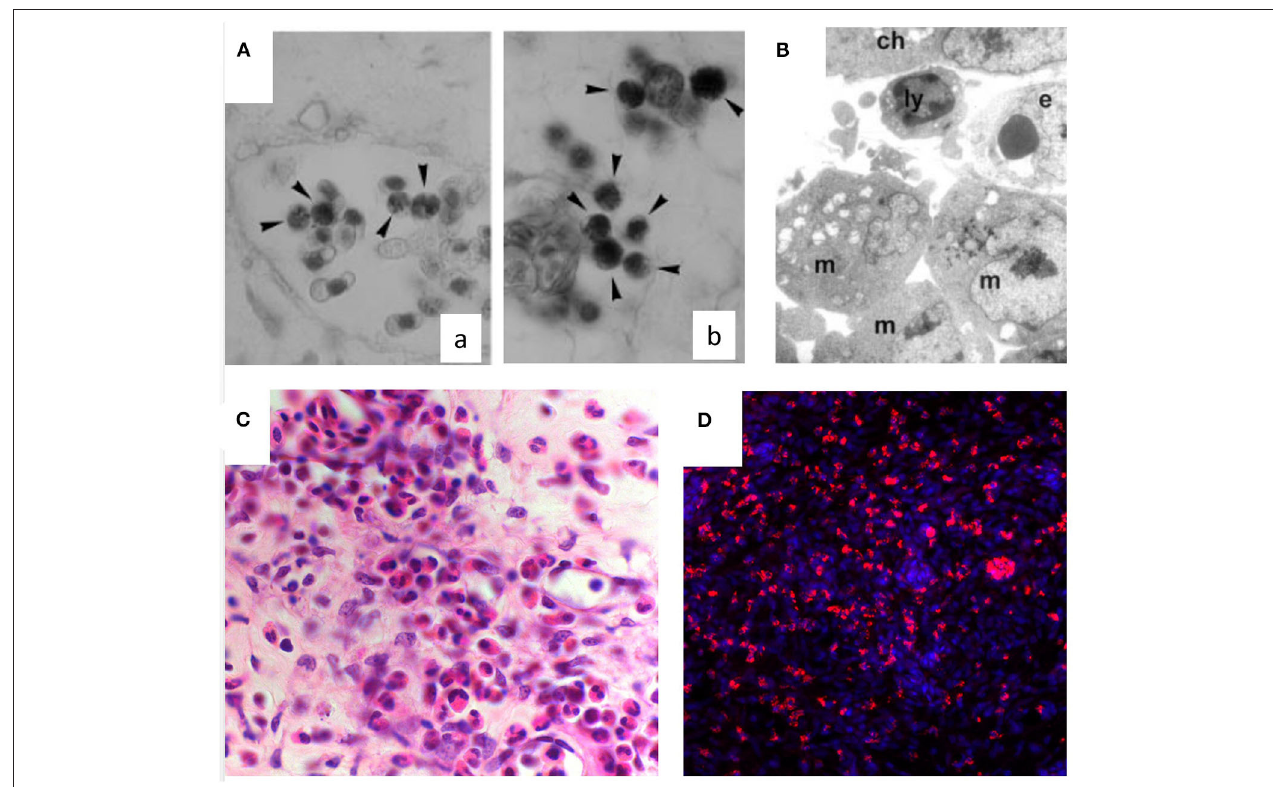
FIGURE 2 | Inflammatory infiltrate in the chick embryo CAM. (A) Naphtol-AS-D-chloroacetate esterase-positive macrophages (arrowheads) in intravascular (a) and perivascular position (b) in the CAM mesoderm. (B) Macrophages (m) and a lymphocyte (ly) are recognizable at ultrastructural level around the endothelium (e) beneath the chorion (ch). (C) Histological sections of quartz filters implanted onto the CAM surface and stained with H&E. Note an increasing number of microvessels (arrows) and of the inflammatory infiltrate inside the marked area [reproduced from (91)]. (D) CD45 + macrophages (in red) infiltrating the CAM following treatment with PDR vitreous. Nuclear staining with DAPI (in